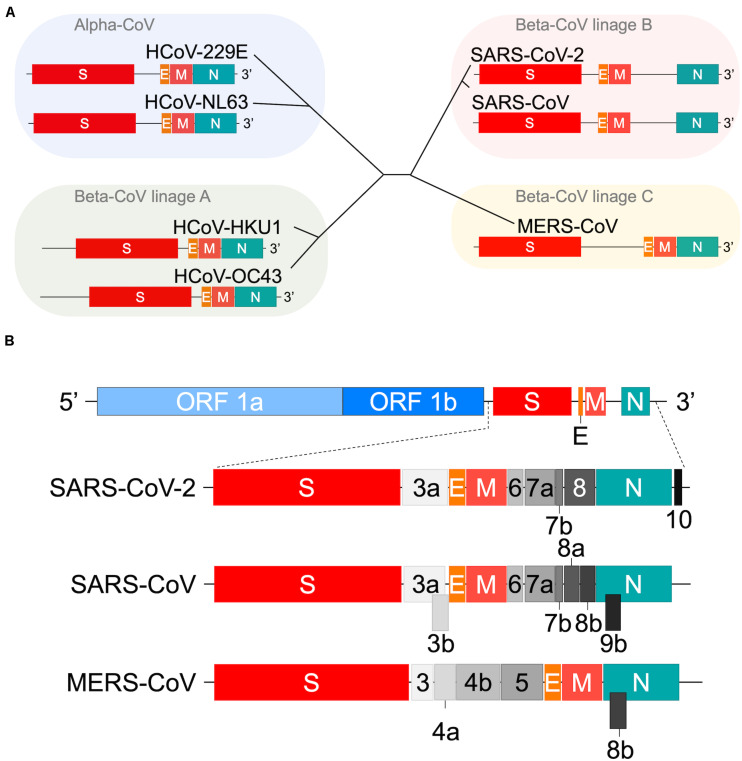
Genome organization of human coronaviruses. (A) Schematic representation of the variable 3′ genomic region. The genome organization of viruses in the four viral groups (Su et al., 2016; Forni et al., 2017) including SARS-CoV-2 (Tse et al., 2020; Wang N. et al., 2020) are shown. Those for various accessory proteins are omitted. The HE orf sequences of HCoV-HKU1 and HCoV-OC43 (Table 3 footnote) are also omitted. The beta-CoV lineage D group that contains some bat viruses only is not presented in this panel. (B) Comparison of SARS-CoV-2, SARS-CoV, and MERS-CoV genomes. All orf sequences in the full-length viral genome are shown (Totura and Baric, 2012; Su et al., 2016; Forni et al., 2017; Cui et al., 2019; Biswas et al., 2020; Hou et al., 2020; Thao et al., 2020; Wang N. et al., 2020; Wu A. et al., 2020; Xie et al., 2020). It has been reported that SARS-CoV-2 contains orf 9b (Cagliani et al., 2020), suggesting a more similar genome structure between SARS-CoV and SARS-CoV-2 than shown in panel B.